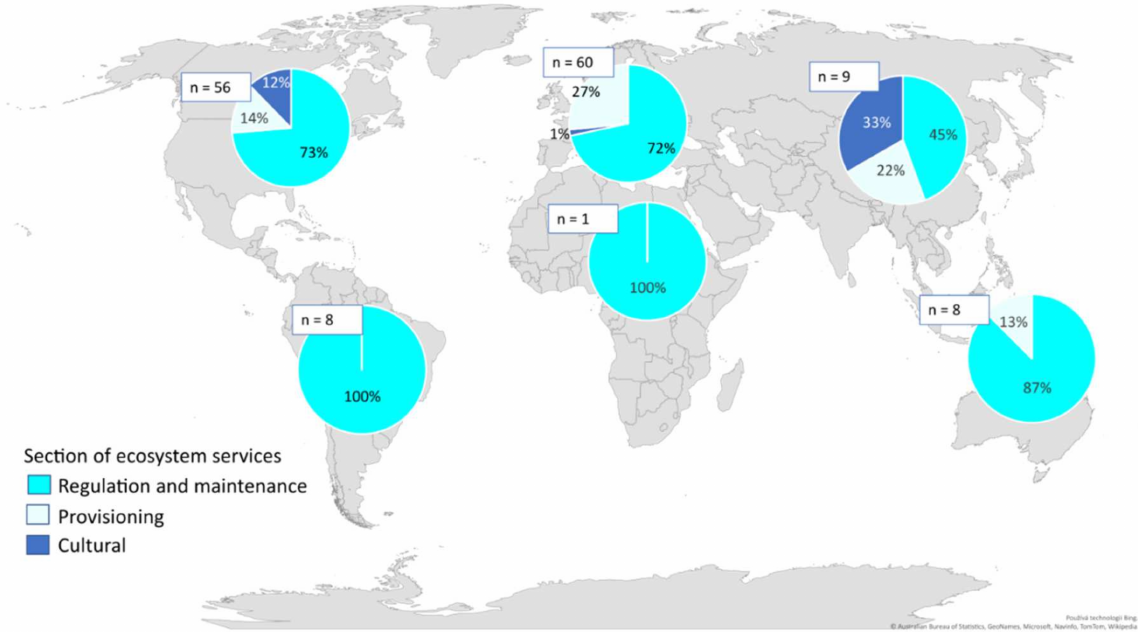
Figure 5. Geographical distribution of sections of ES based on